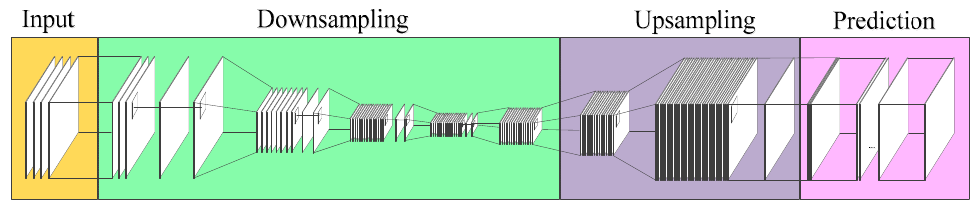
Figure 2. The structure of a dense CNN.